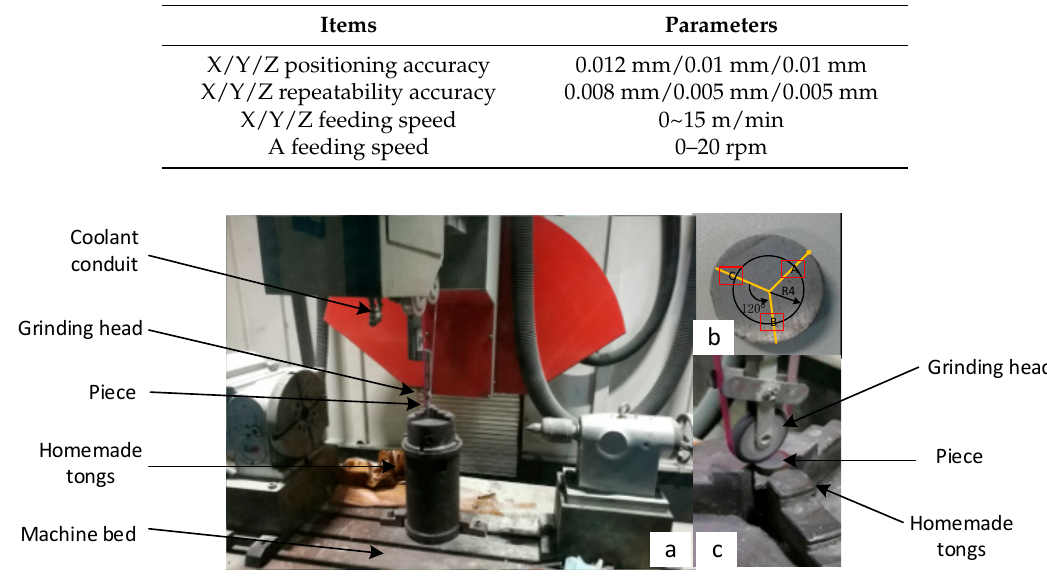
Figure 4. Seven-axes and six-linkage adaptive CNC (Computer Numerical Control) abrasive belt grinding center and the specimen. ( a ) The CNC (Computer Numerical Control) abrasive belt grinding center; ( b ) The specimen and distribution of measuring points; ( c ) The grinding process. Table 1. Axis accuracy of the machining tool.